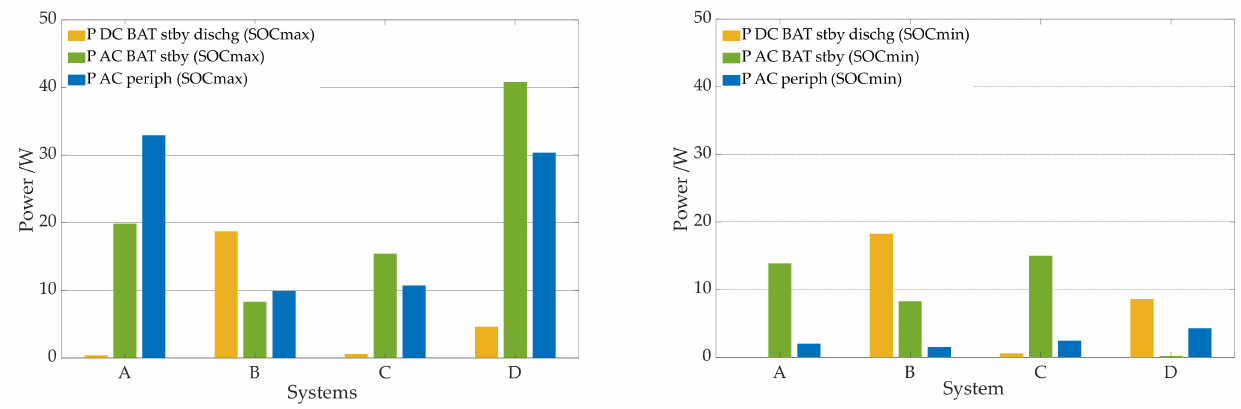
Figure 4. Standby consumption and peripheral consumption (W) of 4 PV storage systems the systems measured when the battery was completely charged ( left ) or discharged ( right ) peripheral